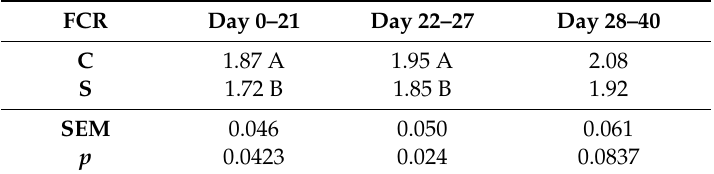
Table 2. E ff ect of Saccharomyces cerevisiae boulardii CNCM I-1079 supplemented diets on feed conversion ratio (FCR) analyzed by trial